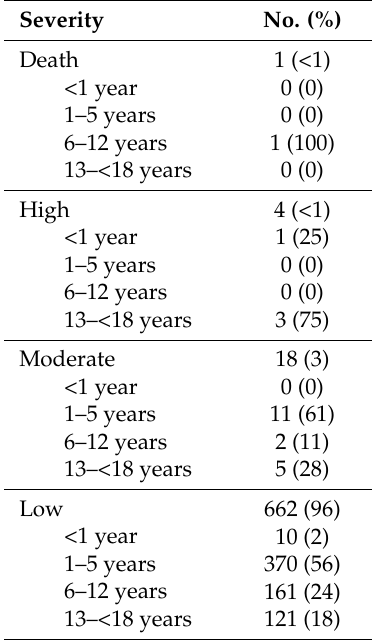
Table 2. Distribution of events in childhood reported by severity of illness/injury and age